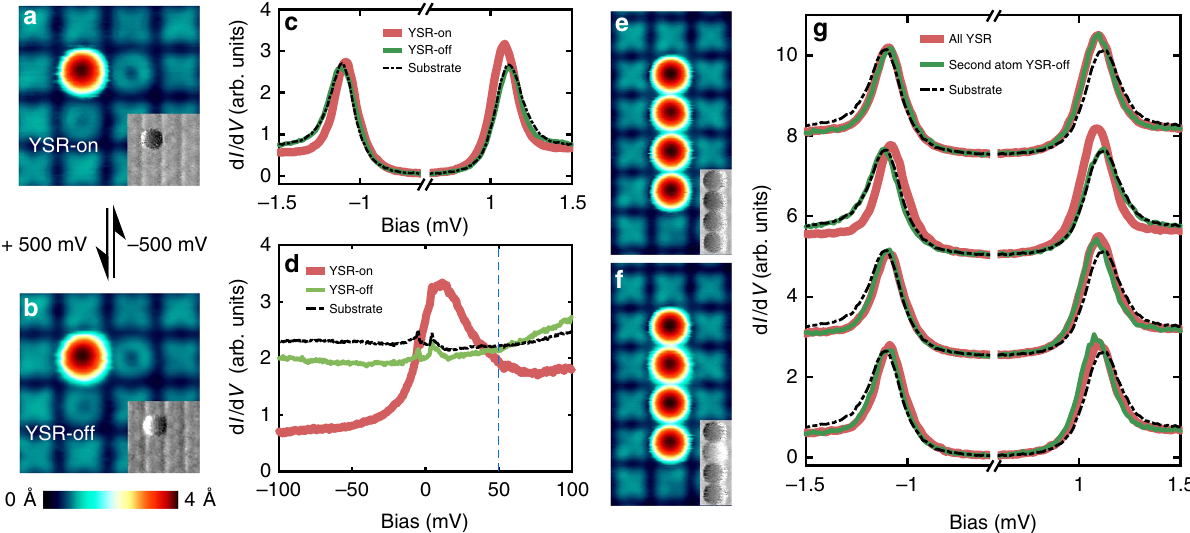
Fig. 2 Switching between YSR-on and YSR-off state in a four-atom chain. a , b STM image showing a single Fe adatom in YSR-on and YSR-off state, respectively. The typical voltage pulse required to switch between the two states is indicated between the two panels. The inset in each panel shows the d I /d V image at V = 50 mV. c , d d I /d V spectra taken with a superconducting tip on the adatom for the two cases shown in a , b , plotted together with the substrate spectrum. e , f STM image of a four-atom chain with the second atom in YSR-on and YSR-off state, respectively. Insets in each panel represent d I / d V images. g d I /d V spectra taken with a superconducting tip on each adatom of the four-atom chain for the two cases shown in e , f , plotted together with the substrate spectrum. The spectra are shifted vertically for each adatom for clarity. Scan parameters: V = 50 mV, I = 100 pA, V mod = 4 mV. Stabilization parameters for STS in c and g : V stab = 2.5 mV, I stab = 100 pA, V mod = 20 μ V and those for d : V stab = 100 mV, I stab = 100 pA, V mod = 3 mV